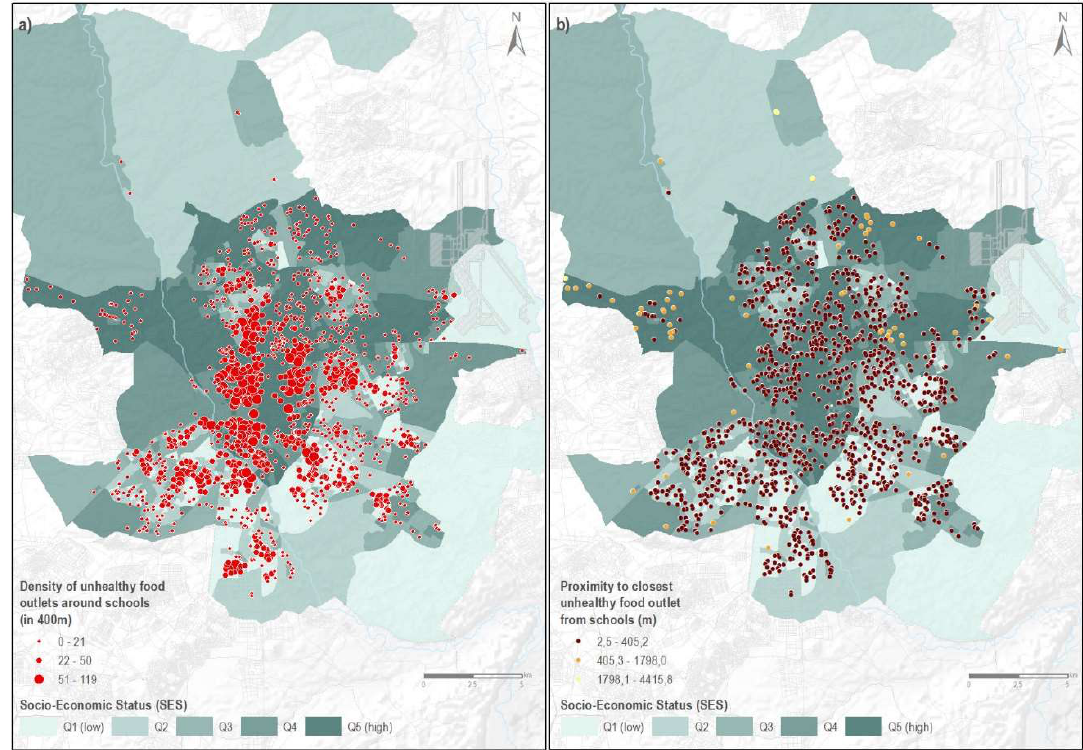
Figure 1. Schools in the city of Madrid (2017): ( a ) by availability of unhealthy outlets around schools; ( b ) by schools’ proximity to the closest unhealthy food source .